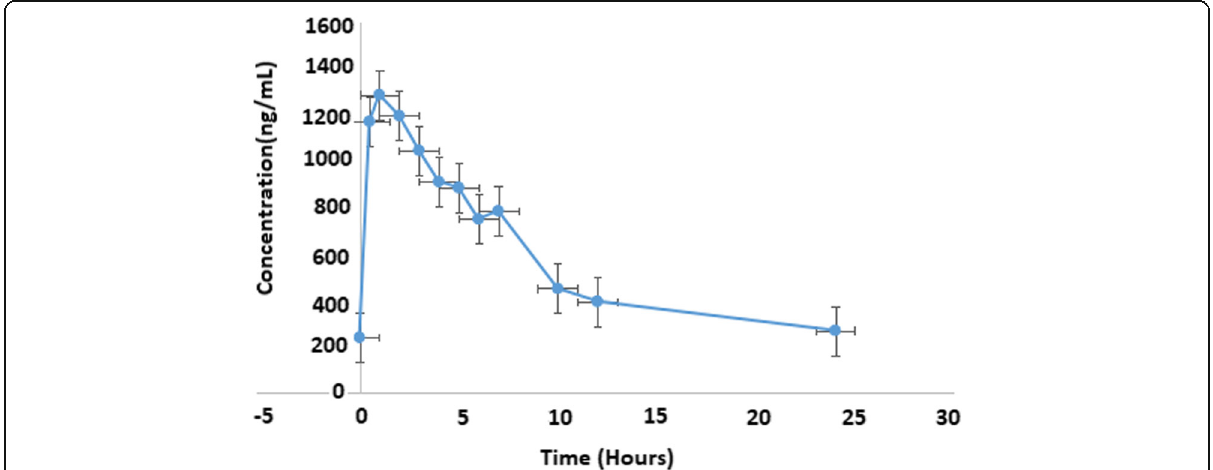
Fig. 6 Concentration vs. time profile over 24 h of daclatasvir in the serum samples ( n = 6) by the administration of receiving a single 60 mg/kg dose of